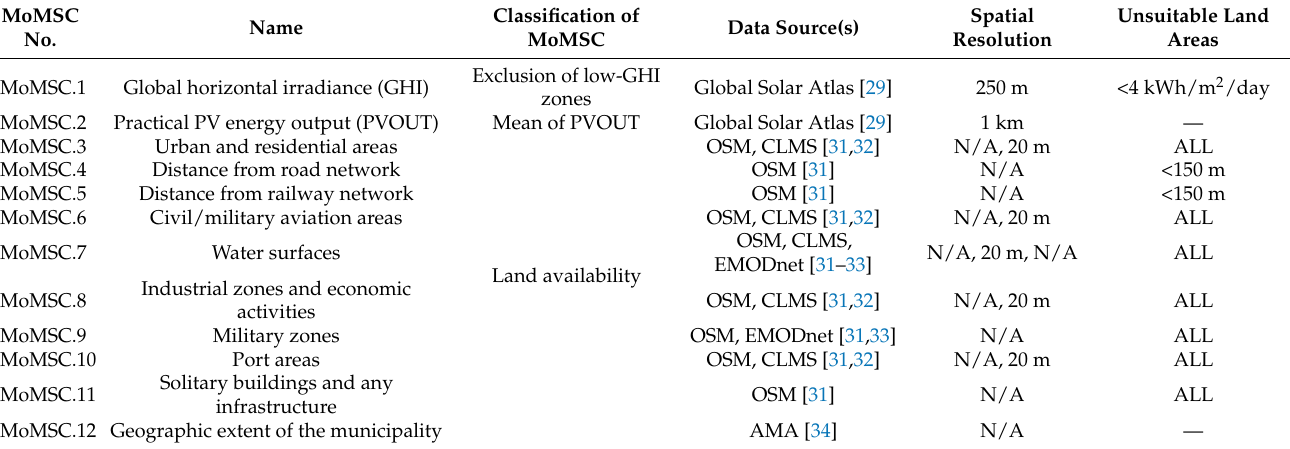
Table 2. MoMSC, classification of the MoMSC and data sources employed in Phase 2 of the proposed DSF-SS. Note 1: OSM, OpenStreetMap; CLMS, Copernicus Land Monitoring Service; AMA, Ag ê ncia para a Modernizaç ã o Administrativa. Note 2: The minimum mapping unit (MMU) of Corine land cover data provided by CLMS is 25